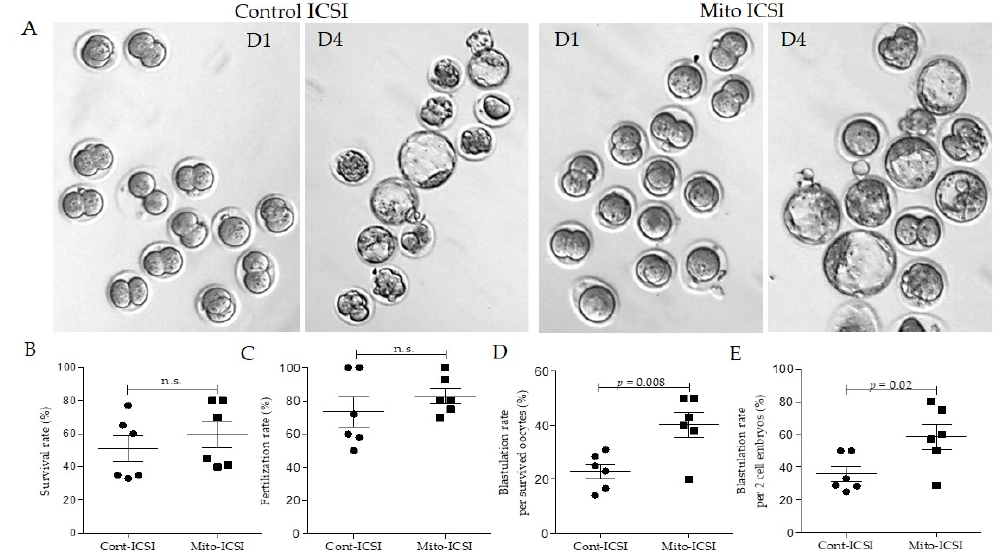
Figure 4. Adipose stem cell mitochondria injection improves blastulation development potentials. ( A ). Representative micrograph of day 1 and day 4 stages of embryos in control and mitochondria- supplemented groups. ( B , C ) The survival rates and fertilization rates were comparable in both groups after ICSI. ( D , E ). A significantly higher blastulation rate was present in the mitochondria supplemented group compared to the control group, ( D ) per survived oocytes and ( E ) per 2-cell embryos.